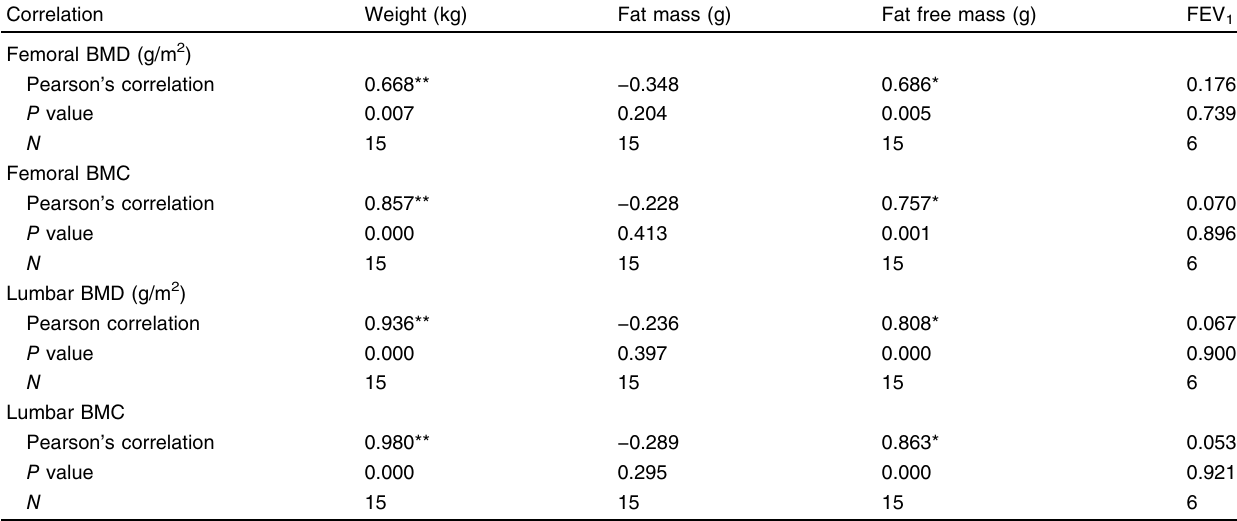
Table 7 Correlation between BMD and many variables in CF patients Correlation Weight (kg) Fat mass (g) Fat free mass (g) FEV 1 Femoral BMD (g/m 2 ) Pearson’s